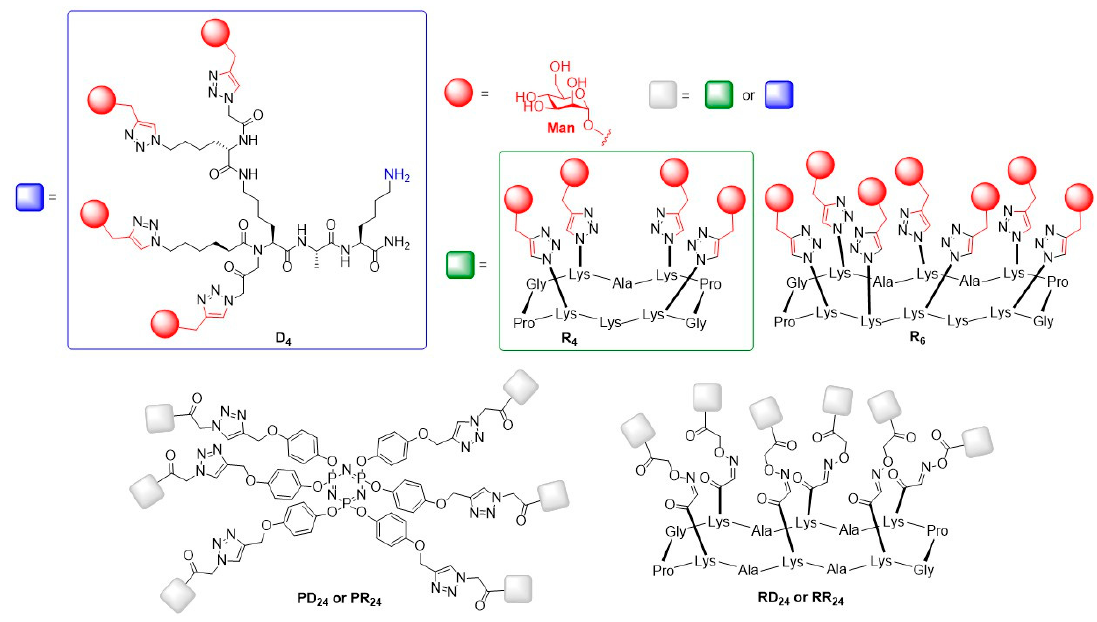
Figure 8. Structures of tetra- (R 4 and D 4 ), hexa- (R 6 ), and 24-valent (PR 24 , PD 16 , RR 16 , RD 16 ) mannosylated glycoclusters.